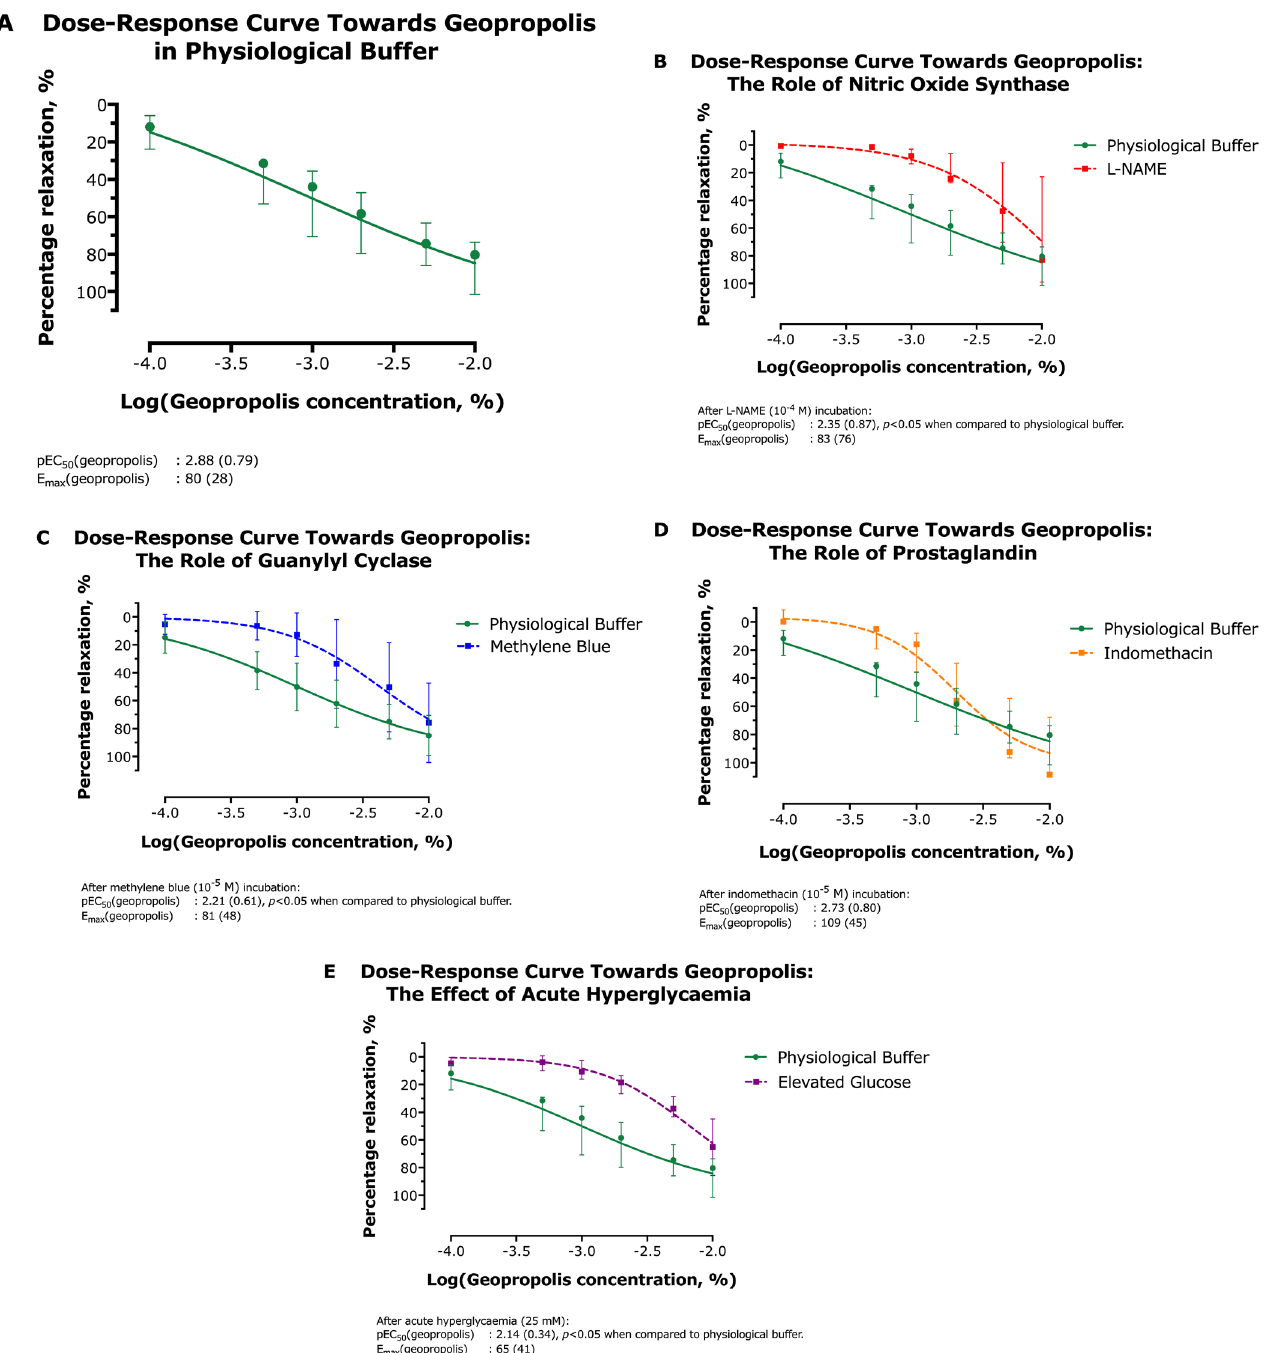
FIGURE 3 – Dose–response curve towards propolis extract under various conditions in the phenylephrine-precontracted aorta (n=6/experiment): A physiological buffer as control, B L-NAME (10 -4 M) as nitric oxide synthase inhibitor, C methylene blue (10 -5 M) as guanylyl cyclase inhibitor, D indomethacin (10 -5 M) as cyclooxygenase inhibitor and E elevated glucose. Data presented as median (interquartile range) and analysed using Wilcoxon signed ranks test to compare with the control. E maximal relaxation; L-NAME, Nomega-Nitro-L-arginine methyl ester; pEC